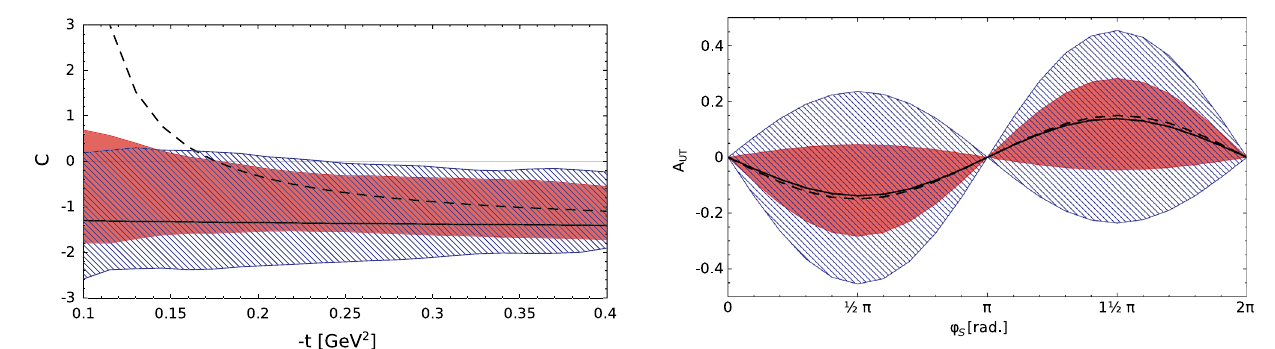
Fig. 8 Ratio C defined in Eq. (25) evaluated with LO and NLO spacelike-to-timelikerelationsfor Q (cid:4) 2 = 4 GeV 2 , ξ = 0 . 1asafunction of t . For the further description see the caption of Fig. 2